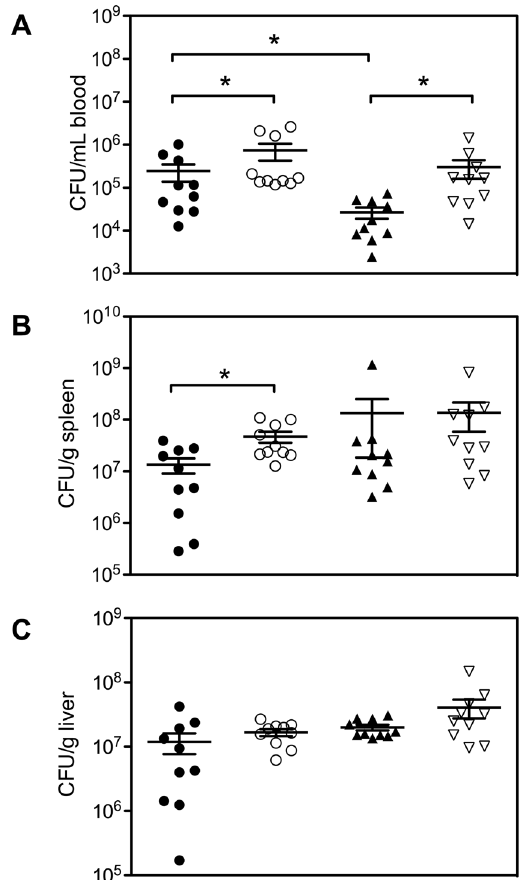
Figure 2. The effect of β 2GPI deficiency in the clearance of E. coli . Mice were infected with 10 8 CFU of E. coli or an equivalent volume of pyrogen-free saline as controls. Blood, spleen and liver were collected aseptically six h post infection, homogenized and cultured on HBA plates overnight. CFU were determined blind and normalized to blood volume or spleen/liver weight. ( A ) Clearance of E. coli from the blood. ( B ) Clearance of E. coli CFU in the spleen ( C ). Clearance of E. coli CFU in the liver. Data was log transformed and is represented as mean and SEM ( n = 10 per group; Mann-Whitney * p < 0.05). Male WT = ● , Male β 2GPI − / − = ○ , Female WT = ▲ , Female β 2GPI − / − = ▽